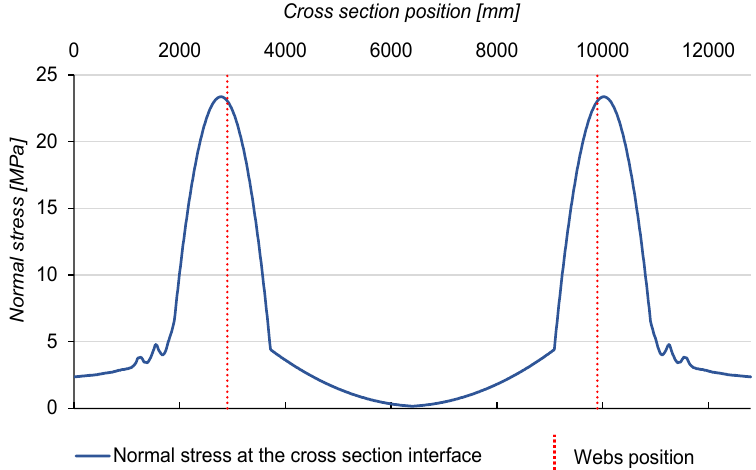
Figure 11. Occurrence of maximum normal stresses in the region of the webs in models with simple box configuration.